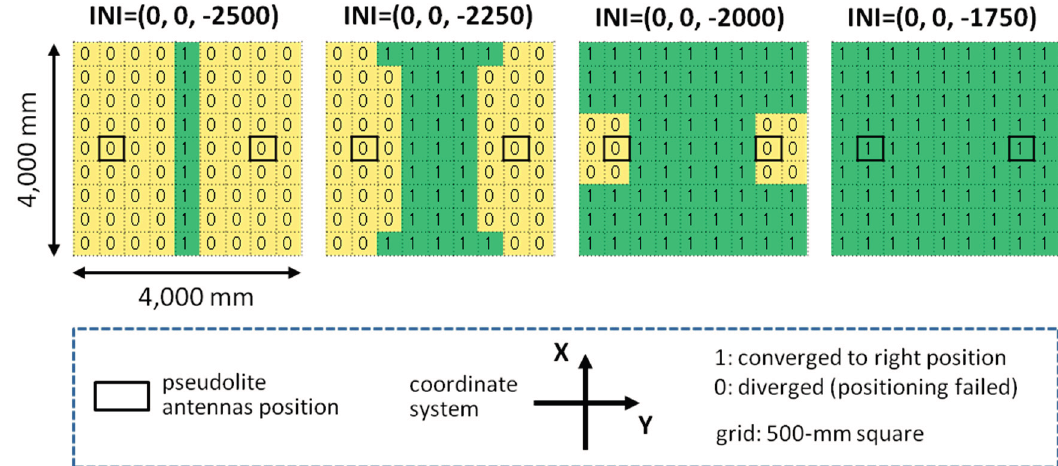
Figure 15. Results of initial value